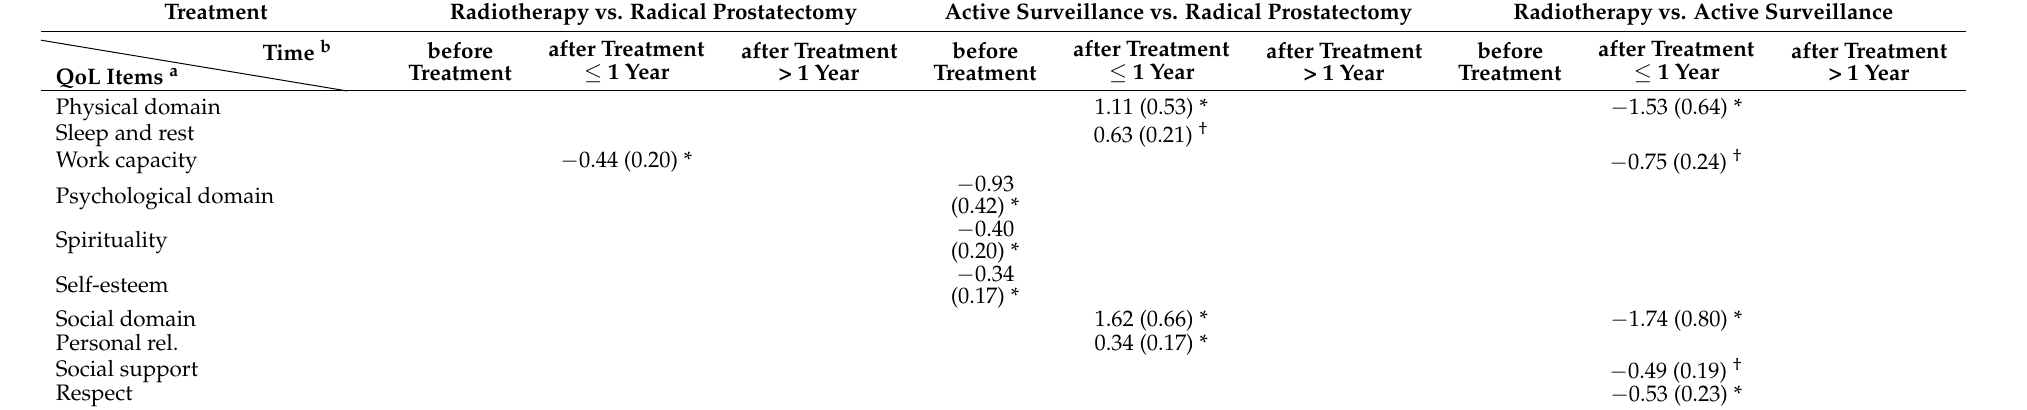
Table 4. Regression coefficients in the interaction between prostate cancer treatment and post-treatment duration with standard errors (in parentheses) on a mix-effects WHOQOL-BREF